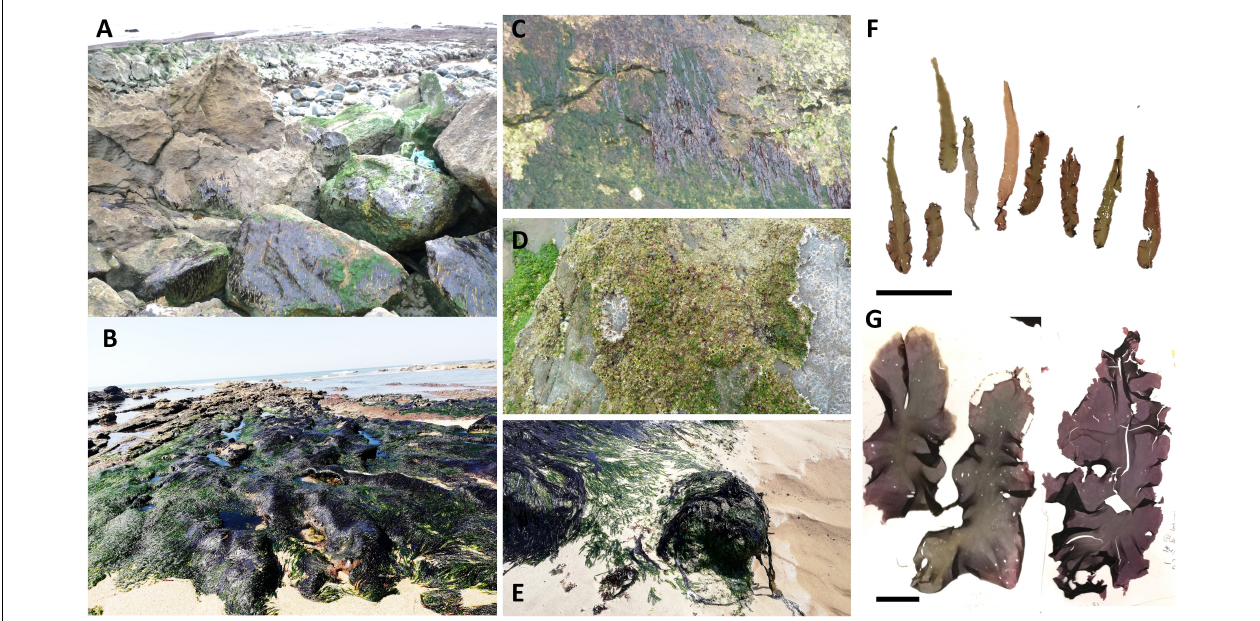
FIGURE 1 | Photographs showing blades of Porphyra species used in this study in the field and in herbariums. (A) P. lineari s in Lisbon, Portugal, (B) P. dioica in Buarcos, (C) P. linearis in walls in Lisbon; (D) Winter P. dioica in Amado, (E) P. dioica in Galicia, (F) herbarium of the small winter form associated to P. linearis and/or the winter form of P. dioica , (G) herbarium samples of the annual lanceolate form associated with annual P. dioica .